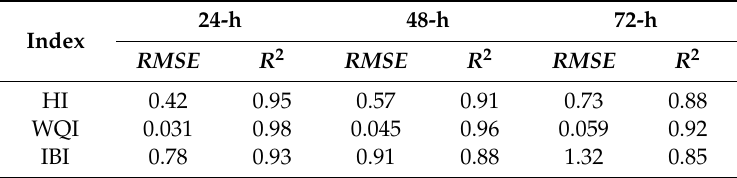
Table 2. Summary performance of the three-phase approach.